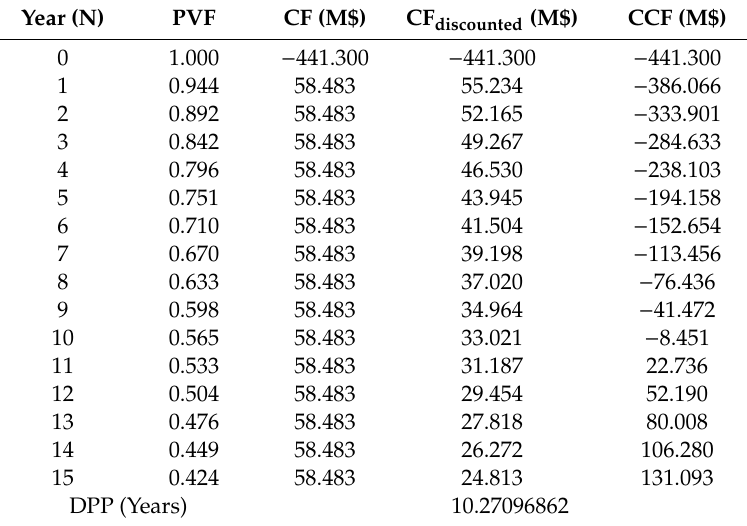
Table 5. Calculation of the discounted payback period.